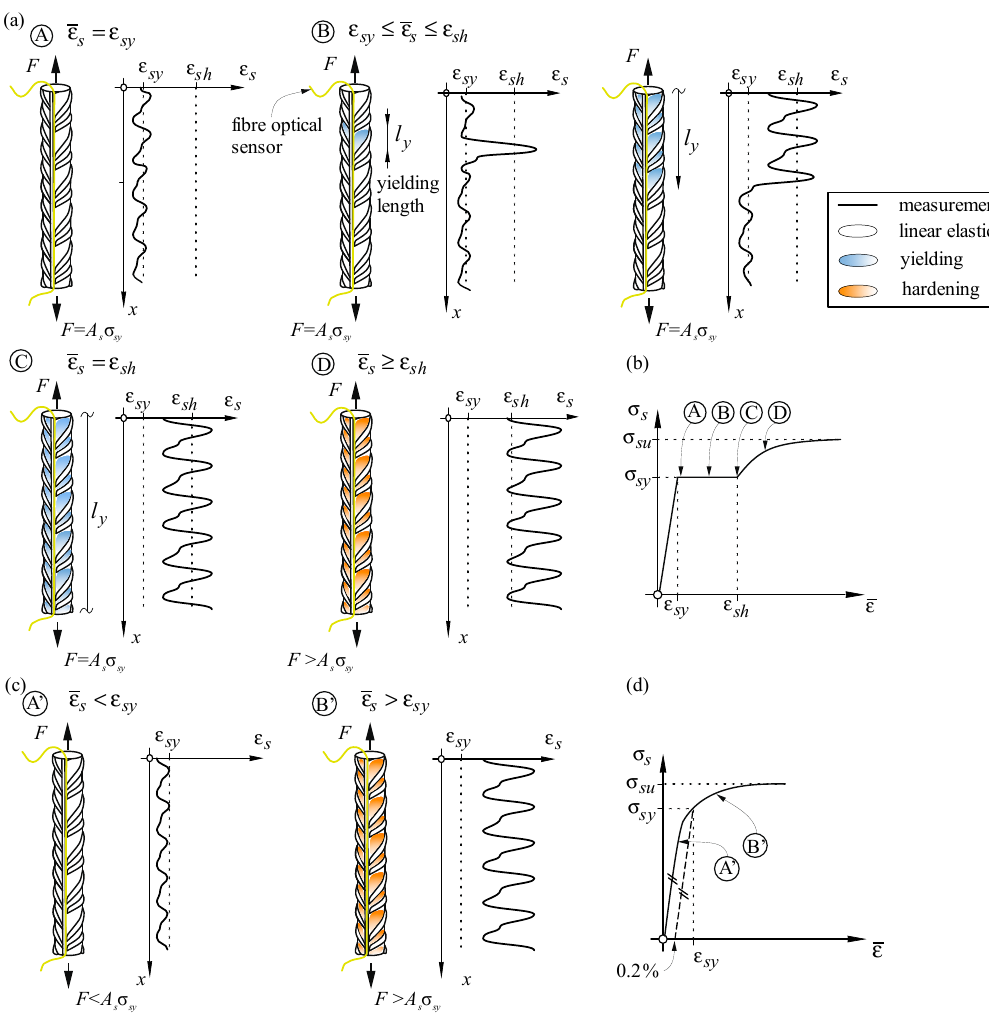
Figure 5. Deformation behaviour of ribbed reinforcing steel bars: ( a ) DFOS strain profiles of QST steel bar at deformation steps A (start of yielding), B (yielding), C (end of yielding) and D (hardening); ( b ) constitutive material law of QST steel; ( c ) DFOS strain profiles of CW steel bar at deformation steps A’ (linear elastic) and B’ (plastic) and ( d ) constitutive material law of the CW steel bar (QST refers to quenched and self-tempered steel, while CW refers to hot-rolled and cold-worked steel).